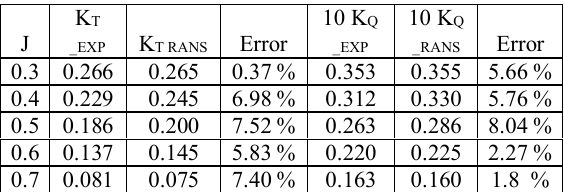
Table 4. Open water characteristic for B 5-75